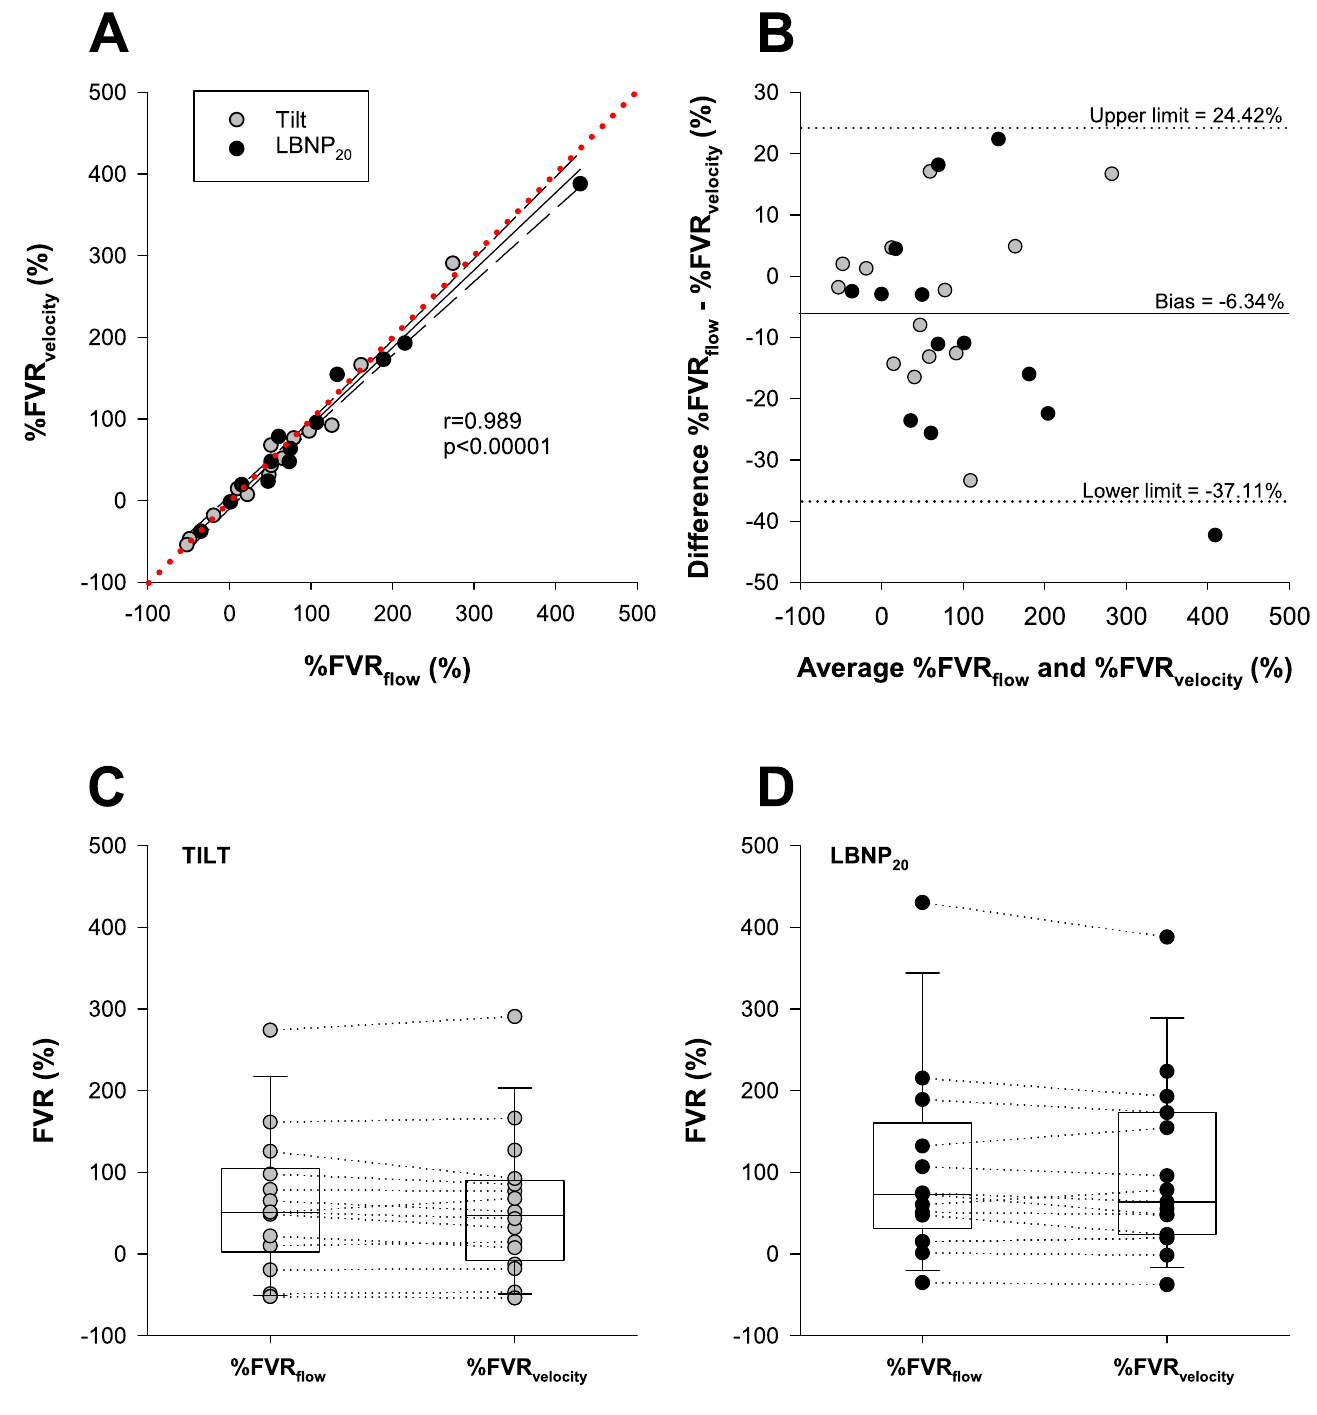
Fig 3. Equivalency between FVR responses to orthostatic stress (percentage change from supine) determined using mean arterial pressure divided by brachial arterial flow (%FVR flow ) or using velocity as a proxy for flow (%FVR velocity ). (A) There was a strong correlation between measurements of %FVR flow and %FVR velocity during orthostatic stress (Tilt, grey) and head-upright tilt with combined -20mmHg lower body negative pressure (LBNP 20 , black). Red dotted line denotes the line of identity. (B) Bland-Altman analyses showed high agreement with minimal bias between measures of %FVR flow and %FVR velocity. There were no significant differences in %FVR flow and %FVR velocity determined at the end of 20 minutes of 60˚ head-upright tilt (C) or after a further 10 minutes of 60˚ head-upright tilt combined with LBNP (D). Abbreviations: FVR, forearm vascular resistance. https://doi.org/10.1371/journal.pone.0224872.g003 PLOS ONE | https://doi.org/10.1371/journal.pone.0224872 November15,